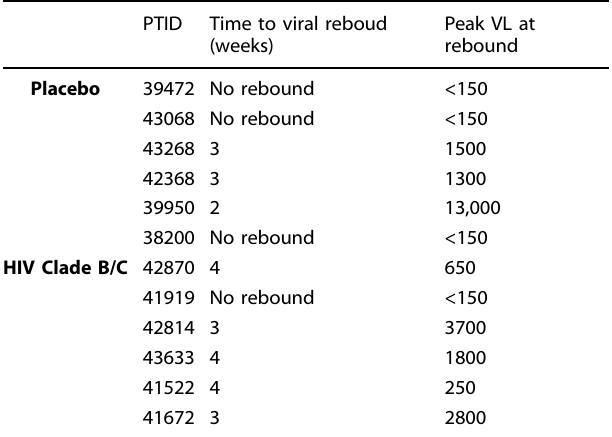
Table 2. Time to viral rebound after discontinuation of ART and peak viral load at